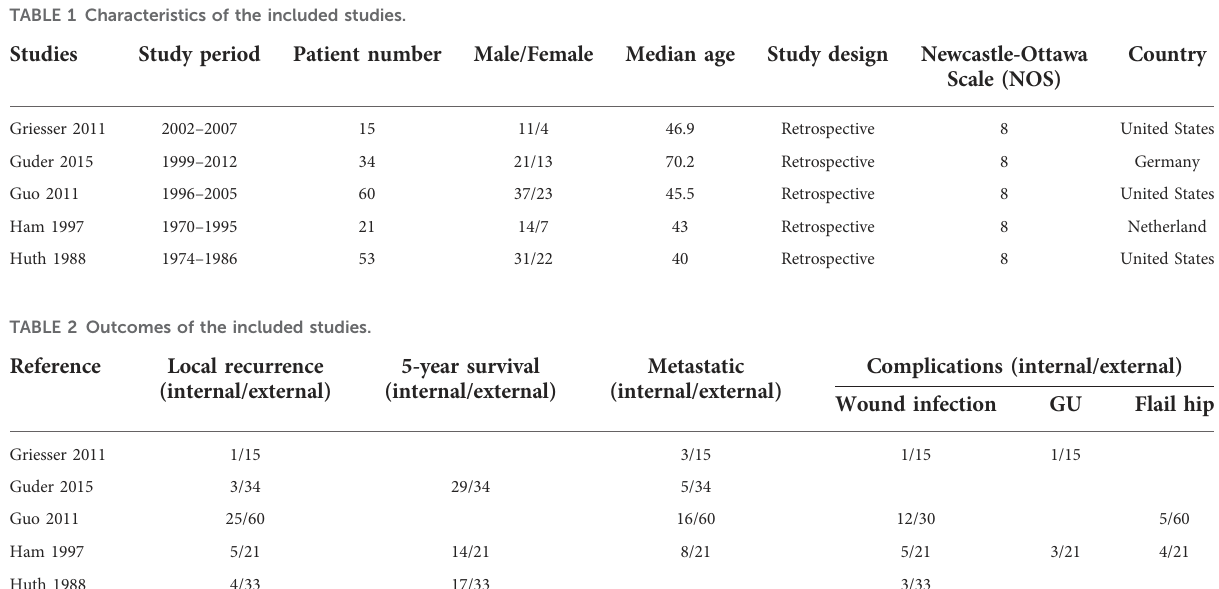
TABLE 1 Characteristics of the included studies.